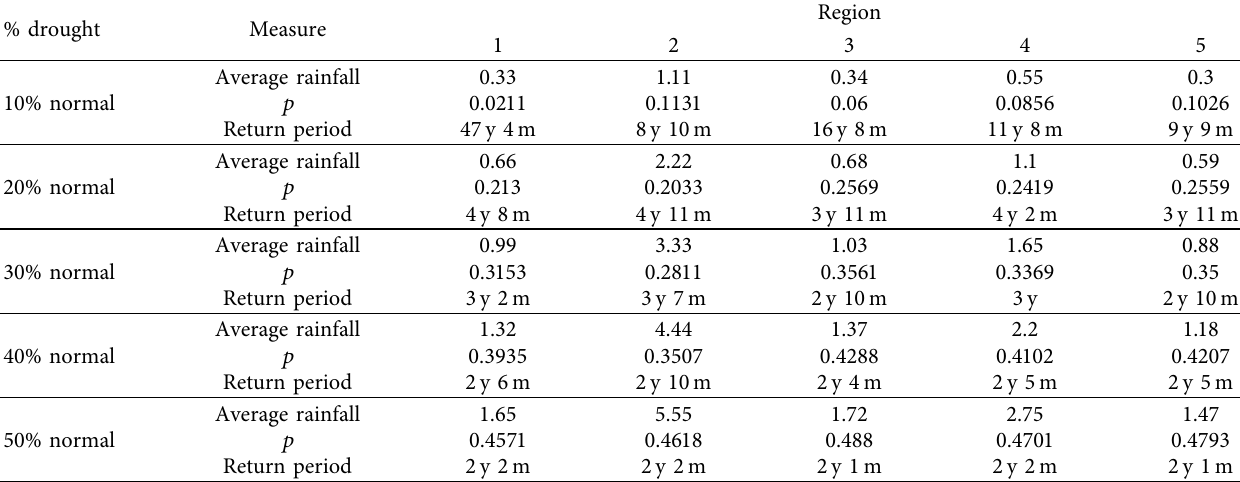
Table 7: Estimated rainfall return period for drought conditions of 10%, 20%, 30%, 40%, and 50% of normal rainfall. %